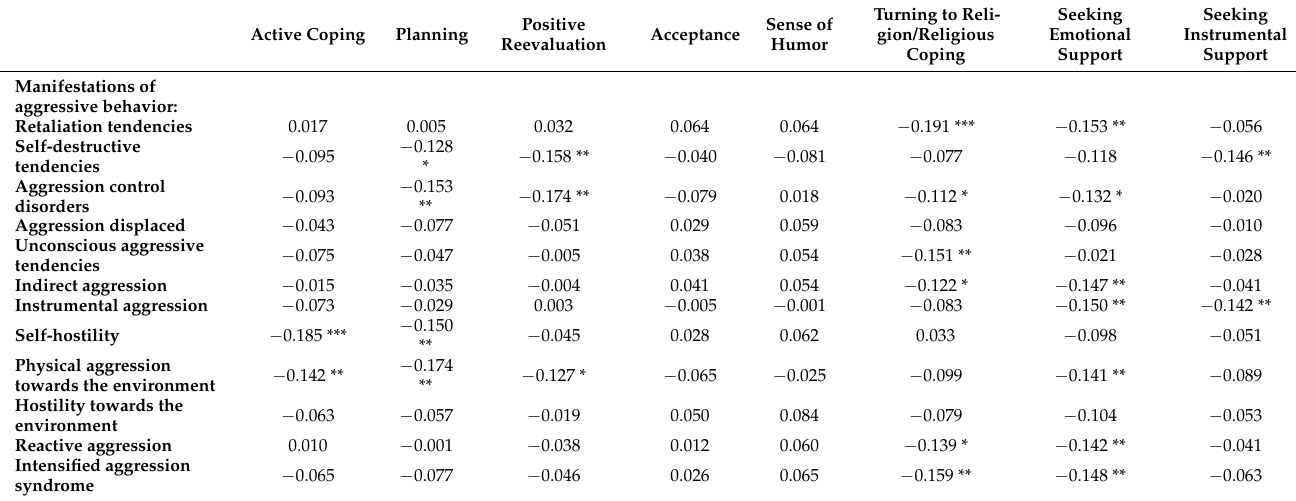
Table 7. Correlations (Pearson’s r) between active stress coping strategies (measurement: MINI-COPE—8 strategies) and the manifestation of aggressive behavior (measurement: IPSA II—a general intensity of the aggression syndrome and its 11 dimensions in the group of seniors ( n =